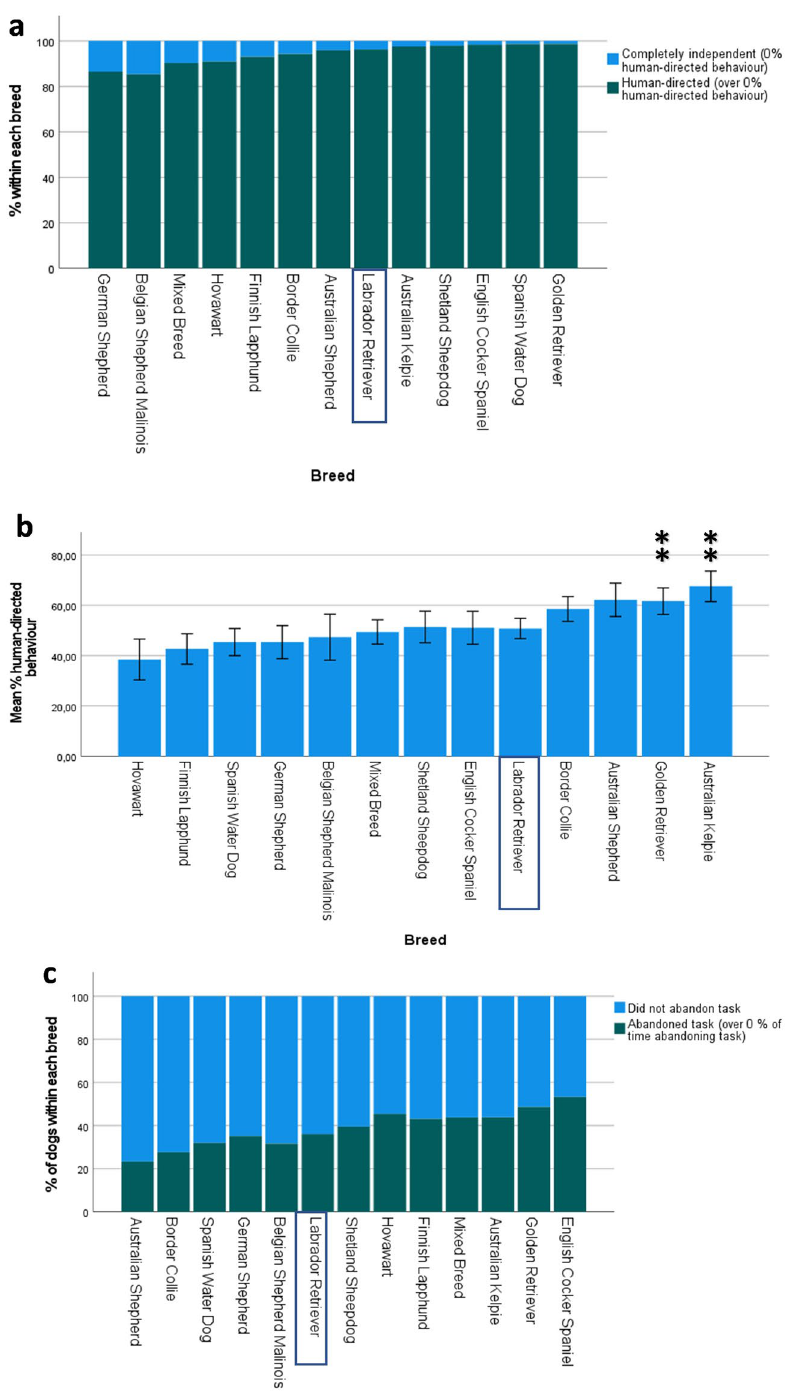
Figure 5. Performance of breeds in the unsolvable task (n = 969). The Labrador Retriever was used as the reference breed. Significant P-values (Bonferroni-corrected) are indicated with asterisks: ***p ≤ 0.001, **p ≤ 0.01, *p ≤ 0.05. ( a ) Percentage of dogs within each breed belonging to the human-directed compared to the completely independent groups during the Unsolvable Task. Breeds have been ordered based on odds ratios, with most independent breeds (most likely to spend 0% of their time on human-directed behaviour) on the left and least independent breeds (least likely to spend 0% of their time on human-directed behaviour) on the right. ( b ) Mean percentage of time (out of a total of 120 s) spent on human-directed behaviour during the unsolvable task for each breed. Error bars represent 95% confidence intervals. Breeds are ordered based on B-values, with lowest amount of time spent on human-directed behaviour on the left and highest amount of time on the right. ( c ) Percentage of dogs within each breed abandoning the task (over 0% of time spent on abandoning task) vs persisting (0% of time spent on abandoning task) with the unsolvable task. Breeds are ordered based on odds ratios, with the most persistent breeds (least likely to abandon task) on the left and the least persistent breeds (most likely to abandon task) on the